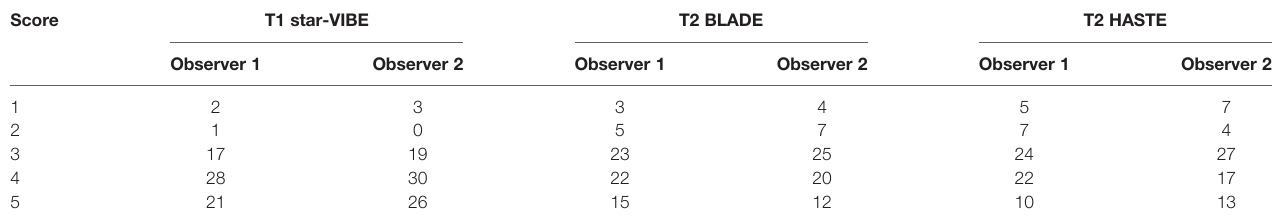
TABLE 5 | The result of image quality score.